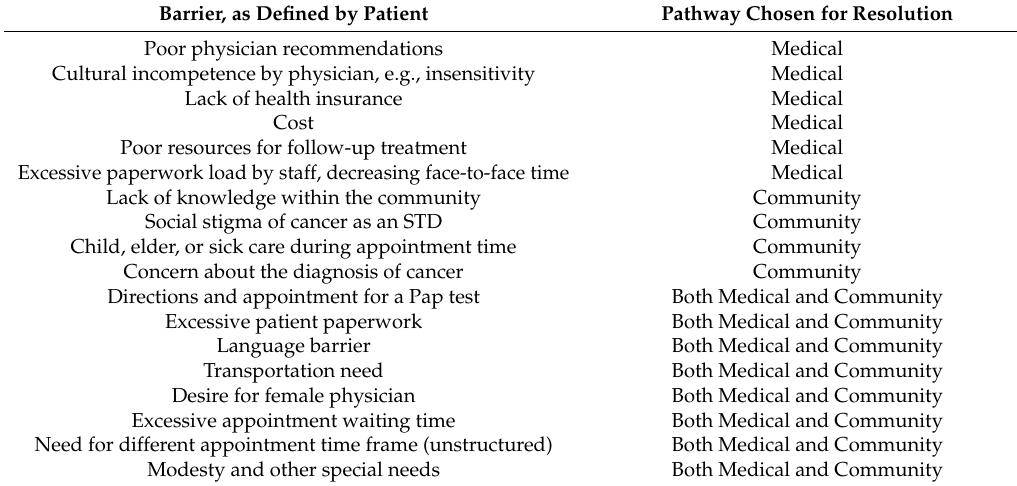
Table 3. Eighteen major barriers identified by the Vietnamese community that were addressed in this study, Column 1, classified according to the pathway(s) used for correction, Column 2. ([37] Tables 1 and 2, pp.